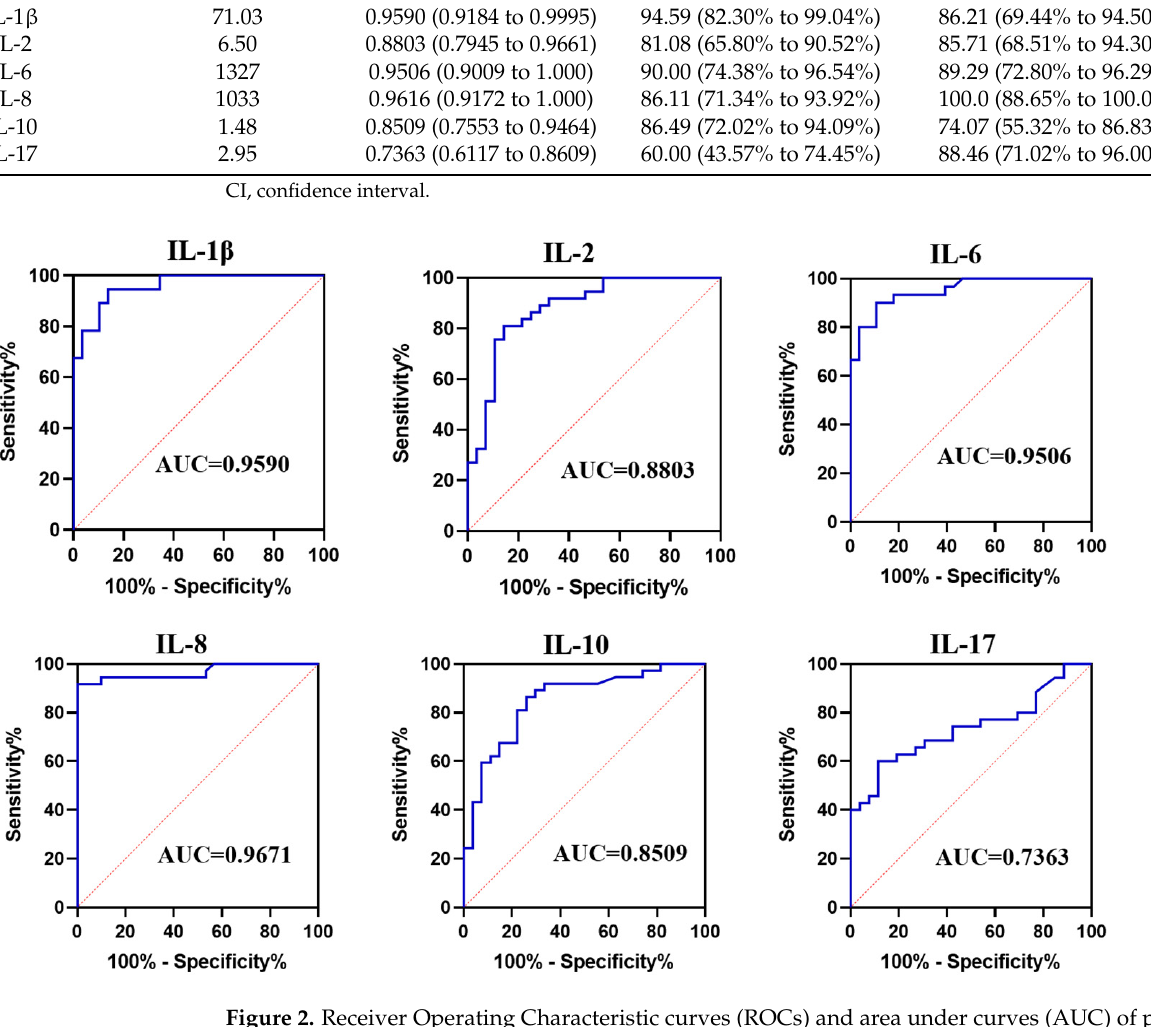
Figure 1. Scatterplots showing the concentration of each biomarker in the three groups. ns, not sig- nificant. * p -value < 0.05; ** p -value < 0.01; *** p -value < 0.001; **** p -value < 0.0001.